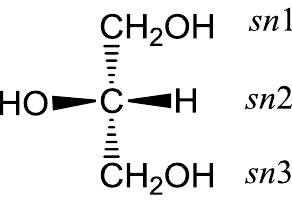
Figure 2. Stereospecific numbering of sn of triacylglycerols. Adopted, with permission, from [13]. Copyright 2002, Marcel Dekker, Inc.